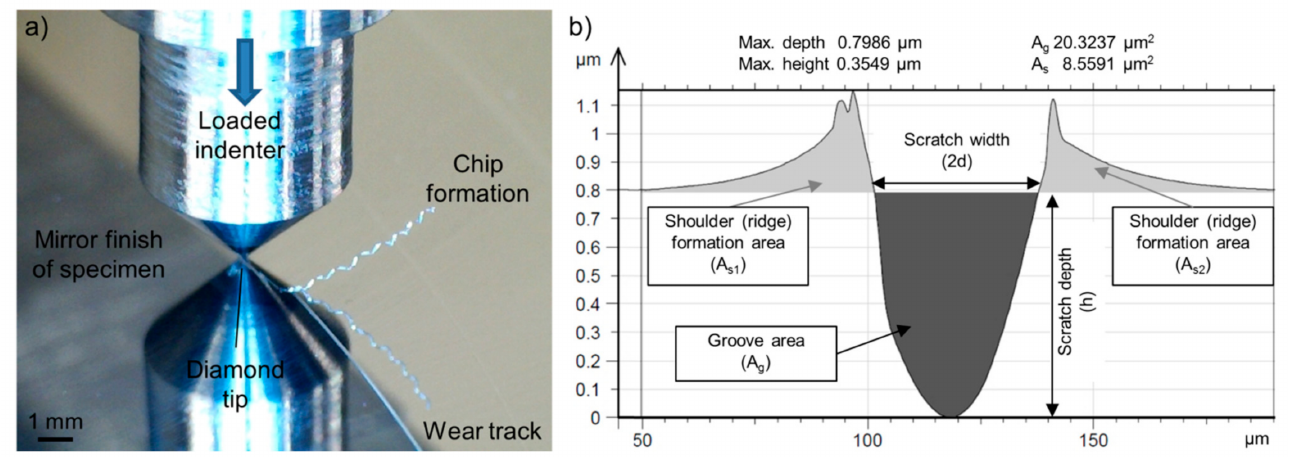
Figure 1. ( a ) Scratch testing (MP material, F N 10.8 N, r 25 µ m, γ 90 ◦ ); ( b ) Extracted groove